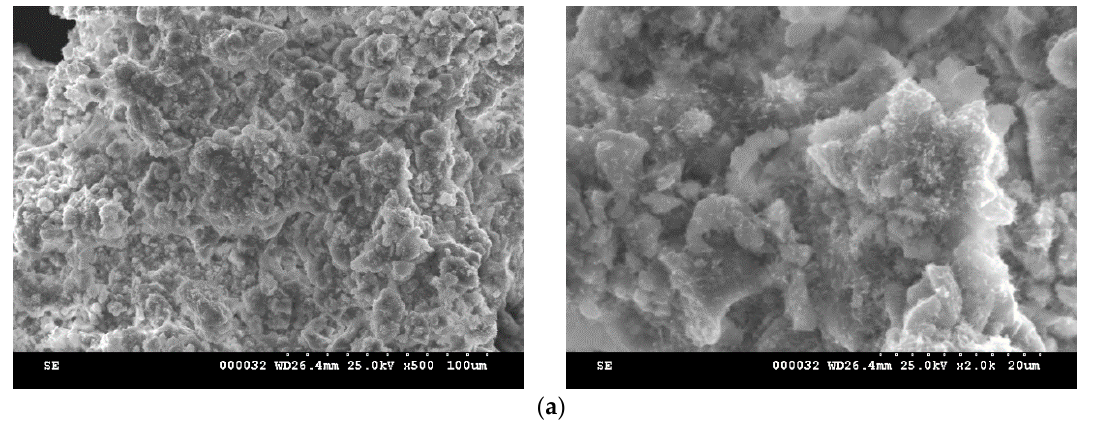
Figure 8. Cont . Figure 8.